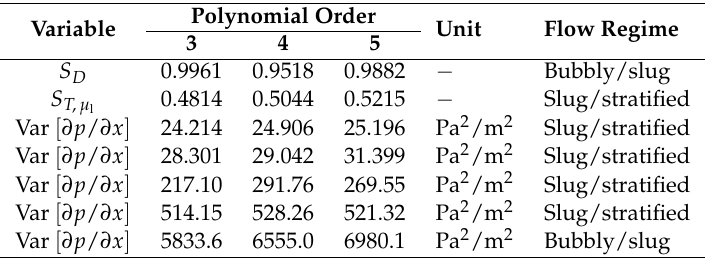
Table 3. Seven cases where the polynomial chaos expansions for pressure drop do not converge with polynomial order. The first column denotes the variable with the maximal change in the last iteration (absolute change for the sensitivities and relative change for the mean and the variance). The values of that variable for polynomial orders 3–5 are given in the next columns, and the last column gives the regime assigned by the flow model. Polynomial Order Variable Unit Flow Regime 3